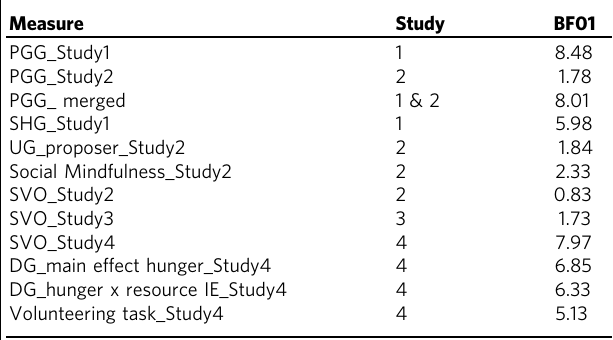
Table 2 Bayes Factors (BF01). BF01 > 1 indicates that a null effect H0 is more likely than an effect of hunger on the given measure (with higher values indicating increasing